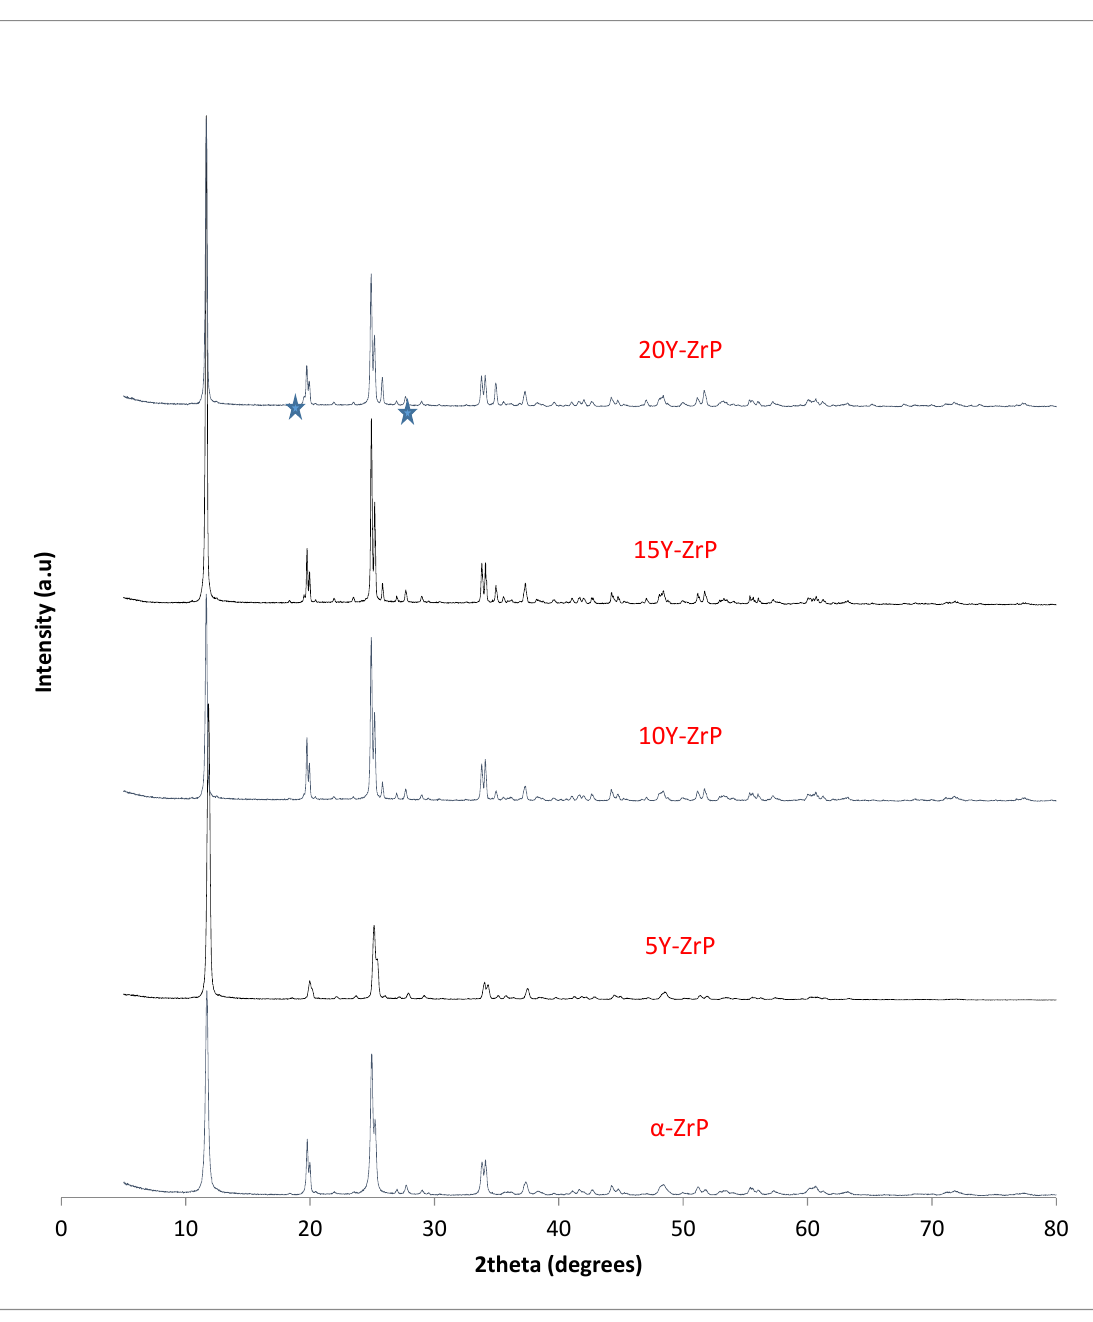
Figure 2. Hydrothermally synthesised Y–ZrP samples.